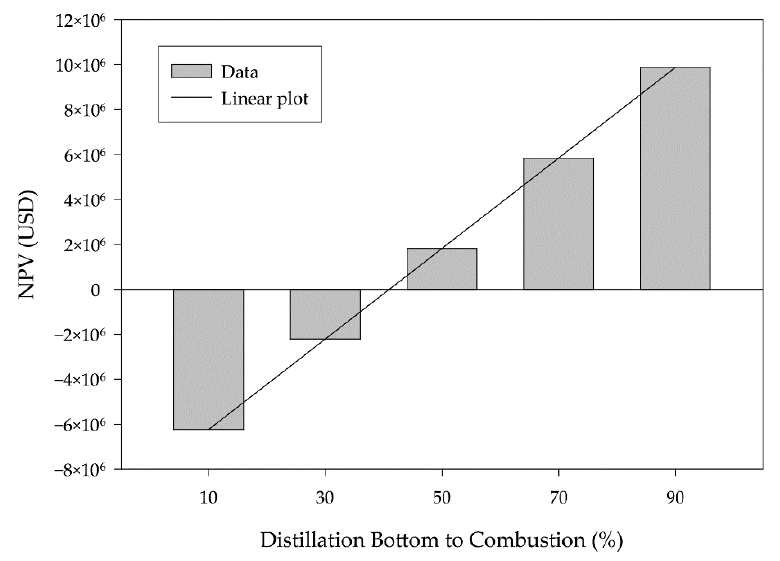
Figure 6. Spent sugar beet pulp bioethanol production process model net present value (NPV) as a function of stillage to combustion percentage.